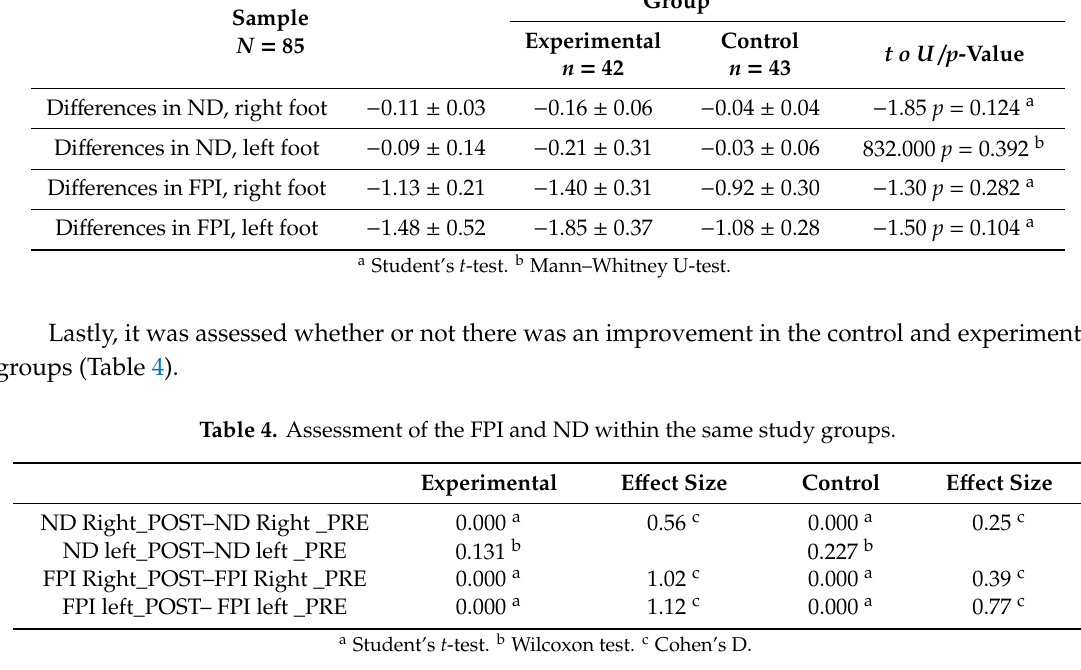
Table 3. Statistical analysis of the pre-intervention and post-intervention Navicular Drop and Foot Posture Index (FPI) values of the right and left feet of the samples and both groups. Sample